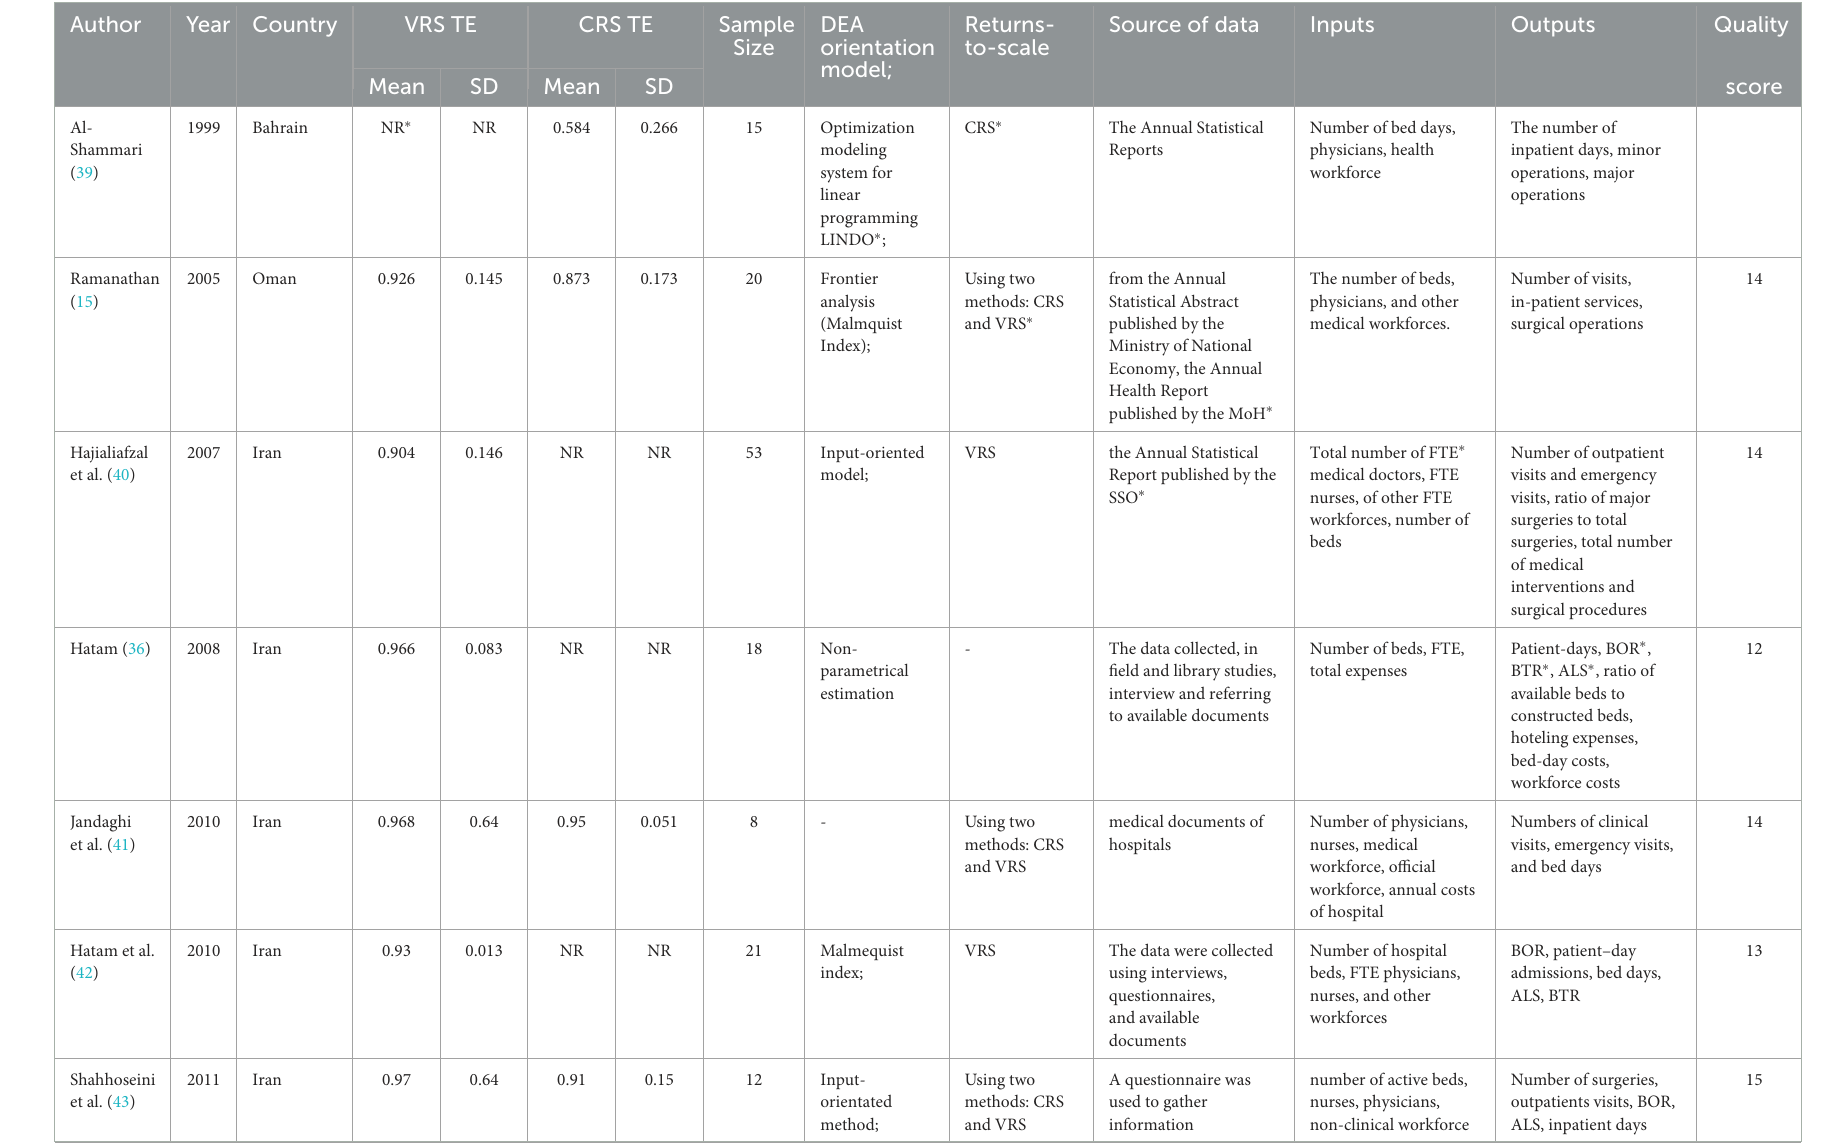
TABLE 2 Characteristics of included studies reported technical efficiency in hospitals located in